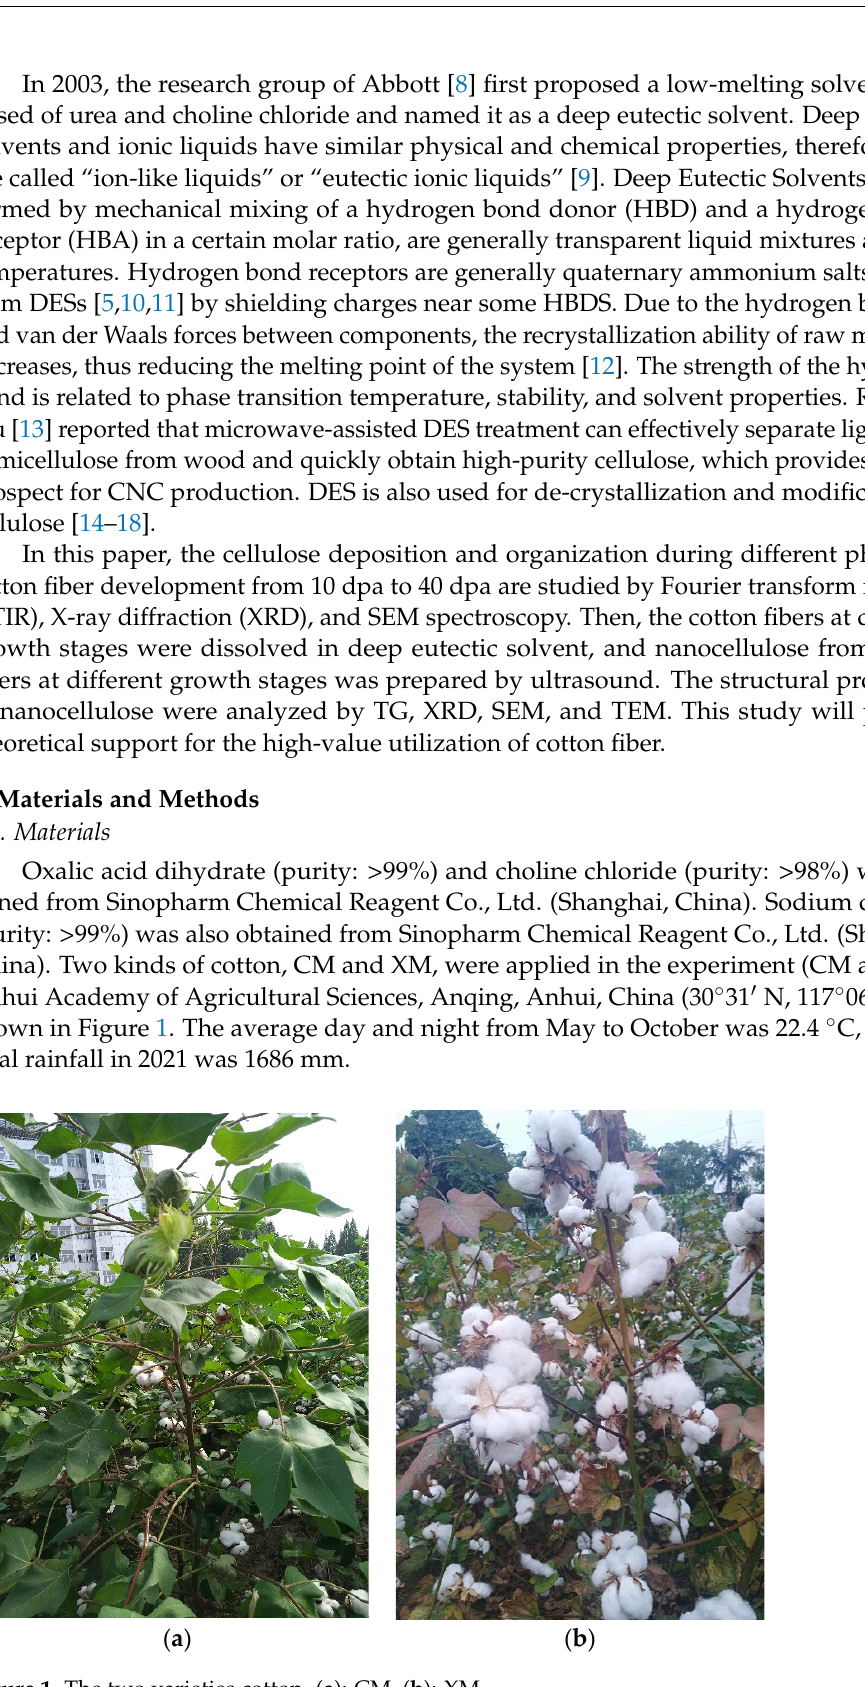
Figure 1. The two varieties cotton. ( a ): CM, ( b ): XM.